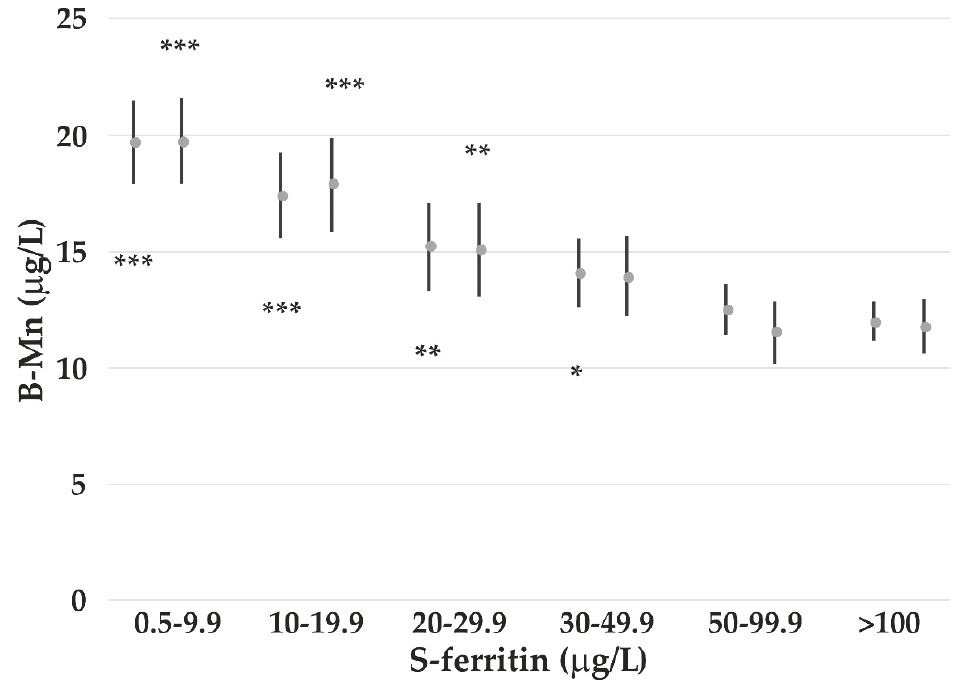
Figure 1. Arithmetic mean (and 95% CI) B-Mn concentrations among all participants (left) and females (right) adjusted for cloudberry consumption. The p -values (*** p < 0.001; ** p < 0.01; * p < 0.05) refer to the subgroup with S-ferritin >100 µg/L as reference for all participants and women, respectively.